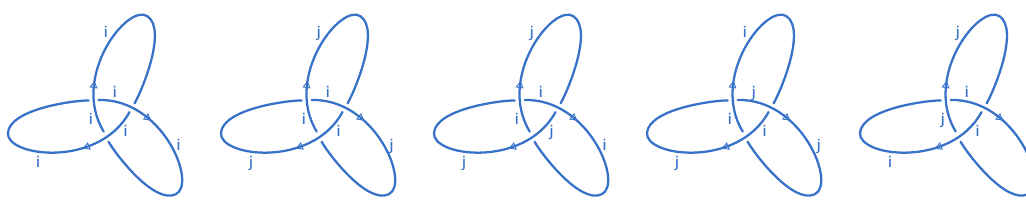
Figure 5 . Arc labelings ‘ for which (cid:11) ( ‘ ) 6 = 0. The labels i; j 2 f 1 ; : : : ; N g and j > i